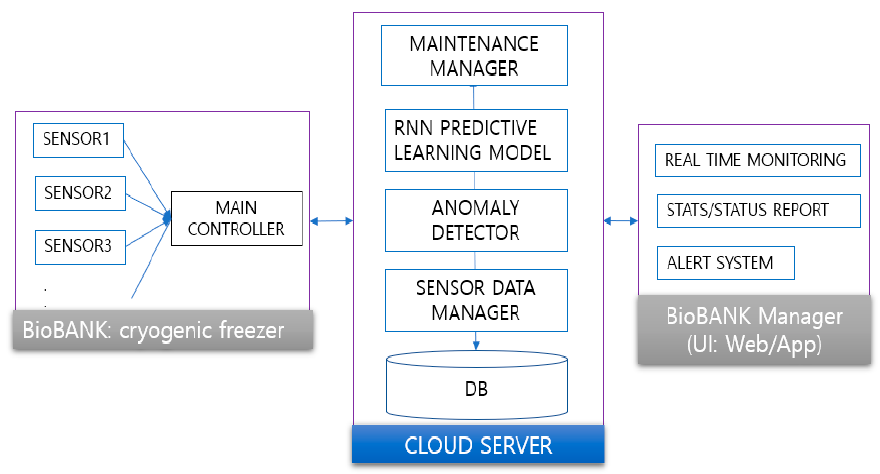
Figure 4. Architecture of IoT-based intelligent monitoring system applying RNN.